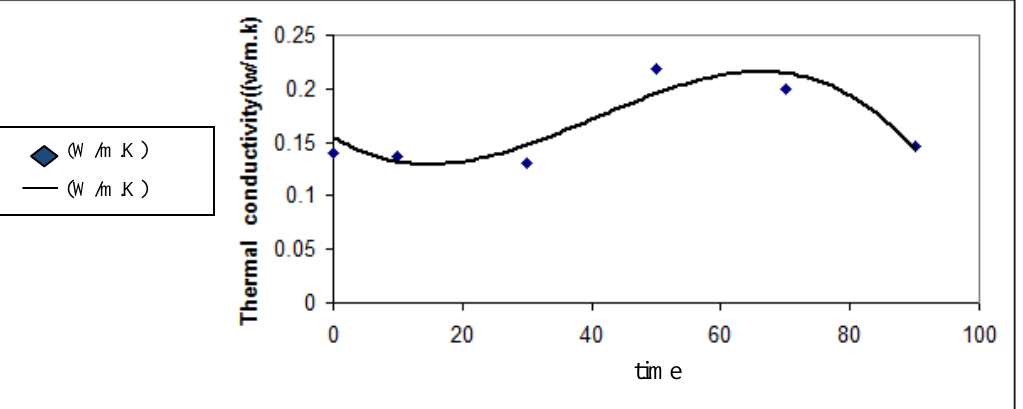
Fig.9: Thermal conductivity for (PMMA and PS) before